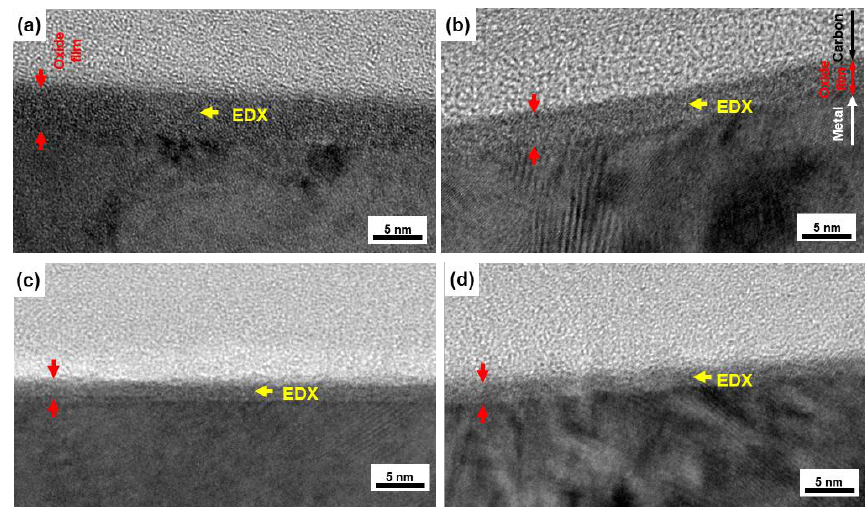
Figure 3. FE-TEM images of oxide films formed on ( a ) Ti–15Zr–4Nb–1Ta, ( b ) Ti–6Al–4V, ( c ) Co–28Cr–6Mo alloy, and ( d ) high-N stainless steel surfaces by anodic polarization up to 0 V vs. SCE in 0.9% NaCl at 37 °C.